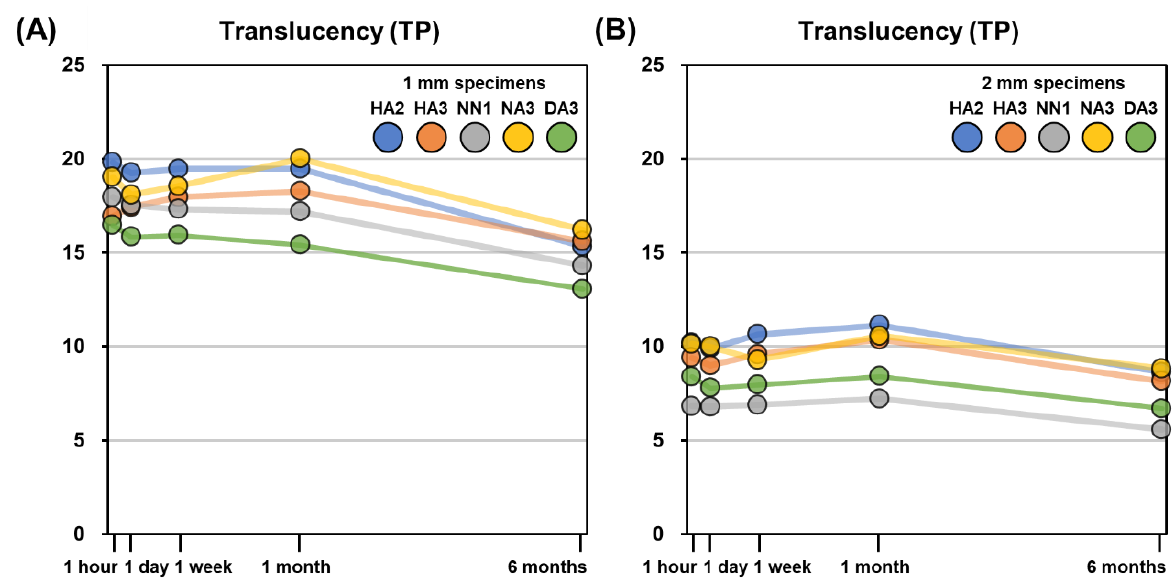
Figure 4. Mean translucency parameter (TP) of the 3D printable material specimens after different storage periods. ( A ) 1 mm specimens. ( B ) 2 mm specimens.